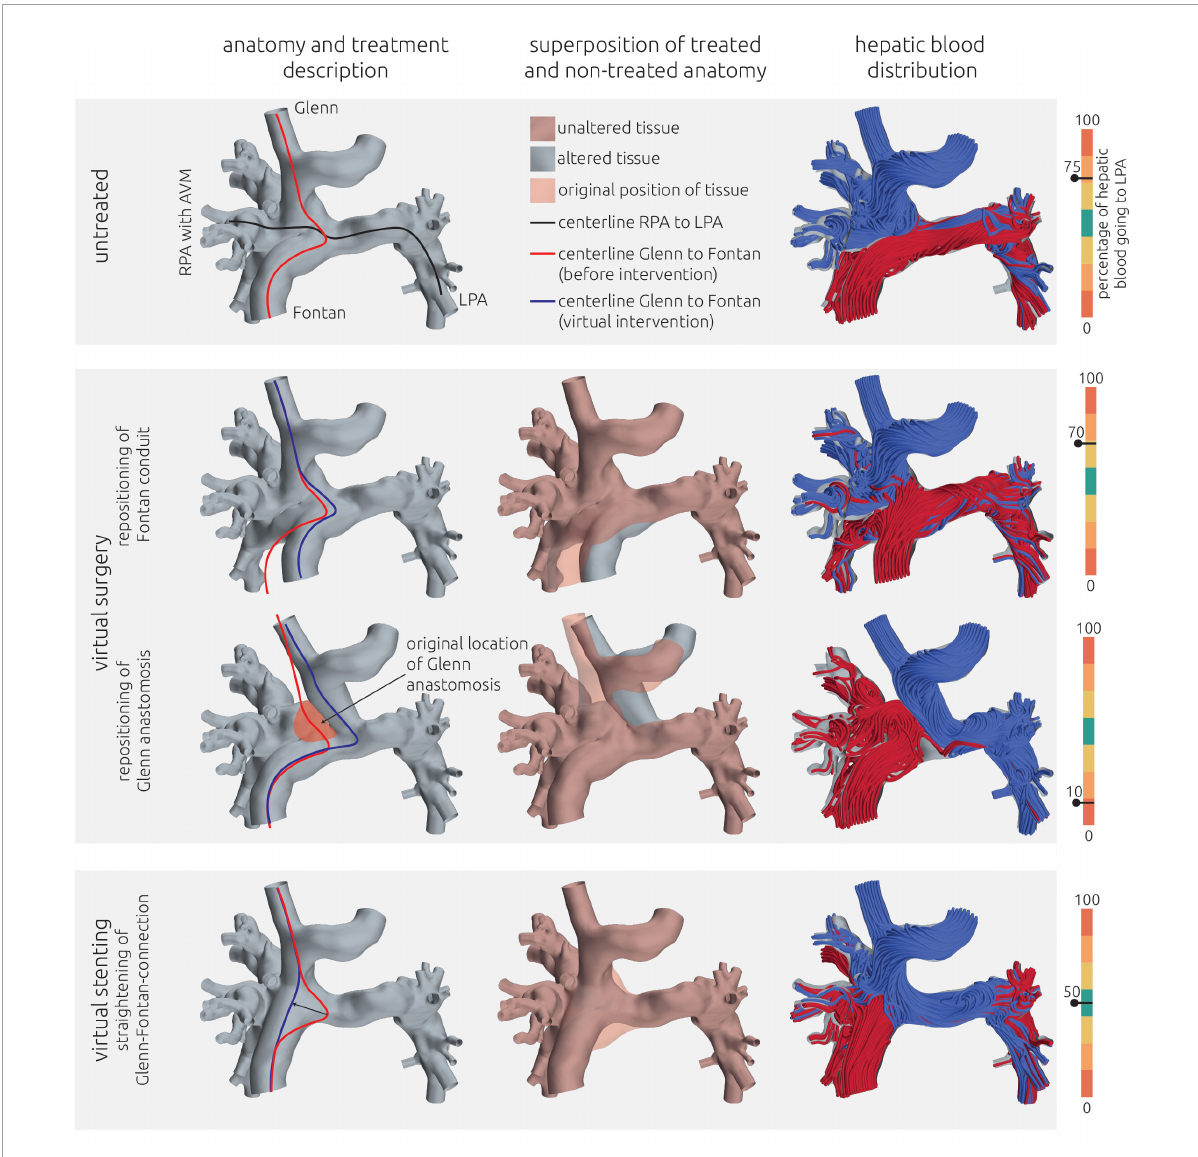
FIGURE5 Visualization of the estimated distribution of hepatic blood flow to the pulmonary arteries for the untreated patient-specific anatomy (top row) as well as two surgical (middle rows) and one interventional treatment option (bottom row) for patient 1. In the left column, the anatomy of the conduit is shown together with centerlines from LPA to RPA (black line) and from SVC to IVC. The original path of the connection from SVC to IVC is highlighted in red, whereas the altered path after virtual treatments is shown in blue. In the central row, the untreated anatomy is superimposed as transparent red surface over the virtually modified anatomy, highlighting all regions that were altered. The right column shows the calculated distribution of hepatic blood (red) into the LPA and RPA, as well as the distribution of blood coming from other veins (blue). Hepatic blood flow distribution is indicated by the gauge to the